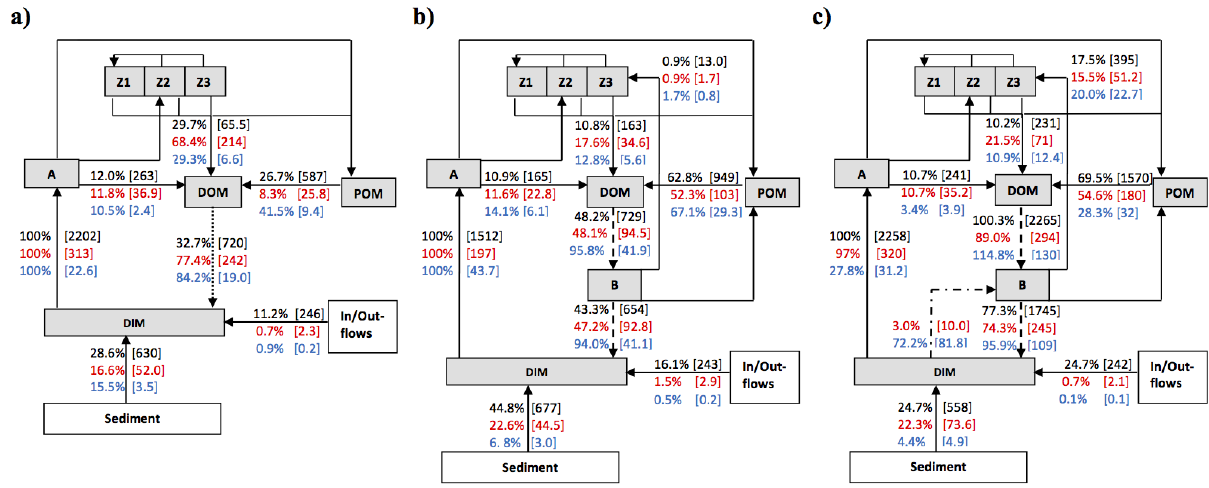
Figure 4. Summary of simulated annual C (black), N (red) and P (blue) pathways for the three configurations: (a) NOBAC, (b) BAC − DIM, and (c) BAC+DIM. Note the dotted, dashed, and dash-dot lines emphasise configuration specific pathways. Selected fluxes relevant to the analysis are displayed as the lake-wide average % relative to the total DIM taken up by phytoplankton and bacteria (where relevant), with the flux rate in brackets ( × 10 − 5 mgL − 1 d − 1